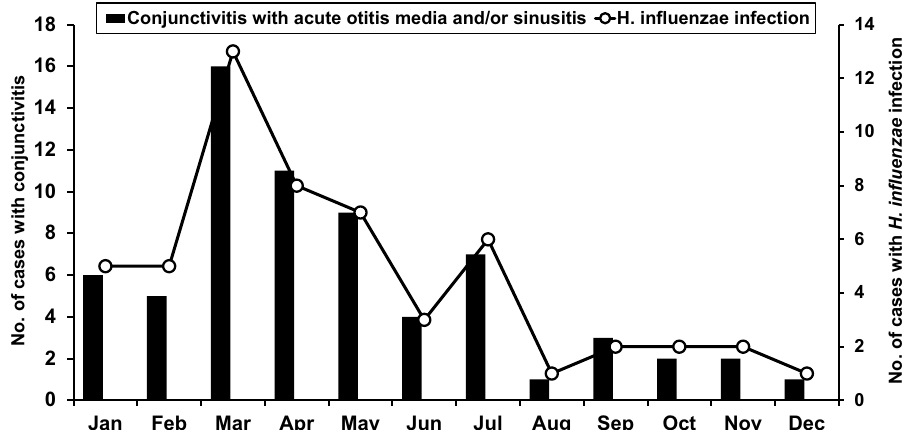
Figure 1. Occurrence of conjunctivitis with acute otitis media and/or acute bacterial paranasal sinusitis and Haemophilus influenzae infection by months. The black bar shows the number of cases with conjunctivitis and acute otitis media and/or acute bacterial paranasal sinusitis in each month. The solid line with circle shows number of cases with conjunctiva culture results of H. influenzae .